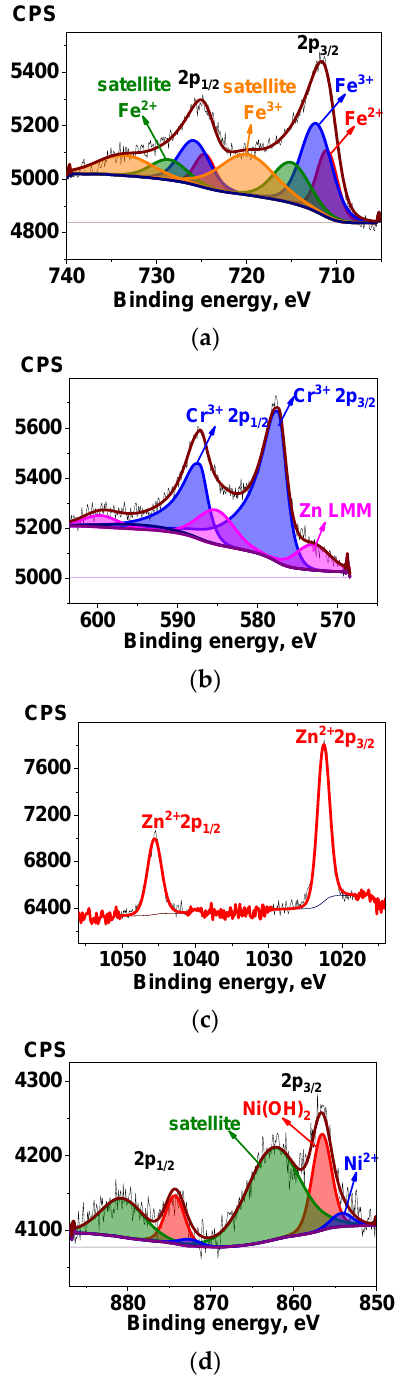
Figure 5. HR XPS spectra of SiO 2 -Fe 3 O 4 -PPP-Cr-Zn in the Fe 2p ( a ); Cr 2p ( b ); Zn 2p ( c ) regions; and Ni 2p ( d ) of SiO 2 -Fe 3 O 4 -PPP-Cr-Ni.